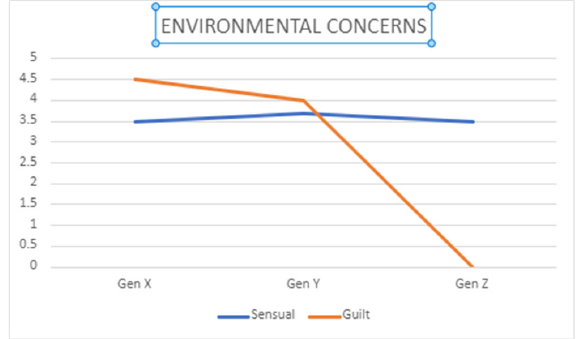
Fig. 5. The interaction effect of